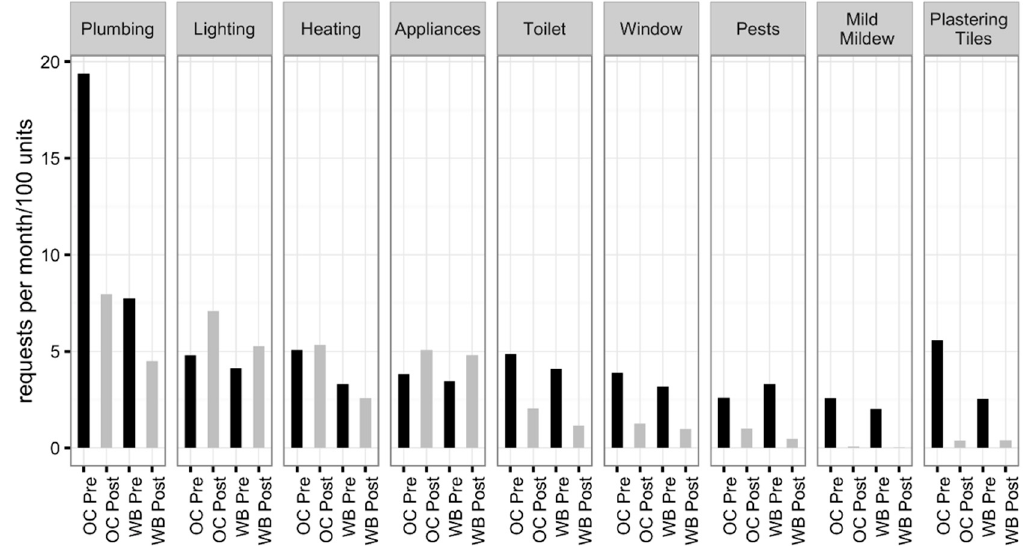
Figure 1. Average monthly work order requests per development in pre- and post-renovated conditions.